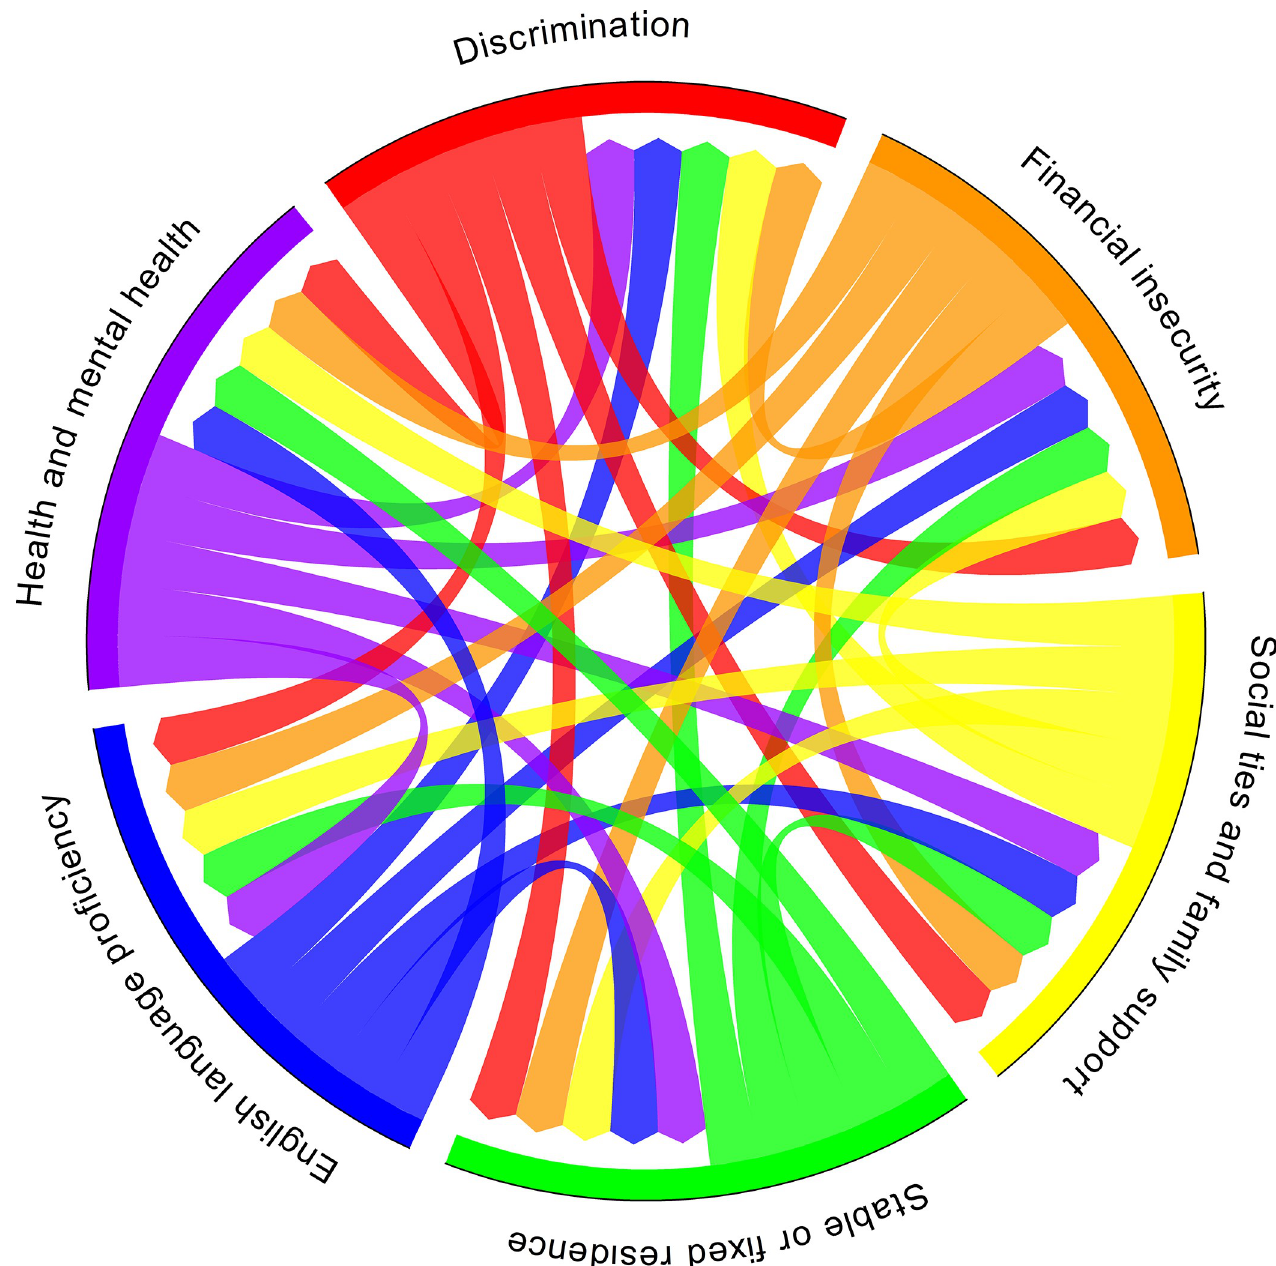
Fig 2. Intersecting perceived structural